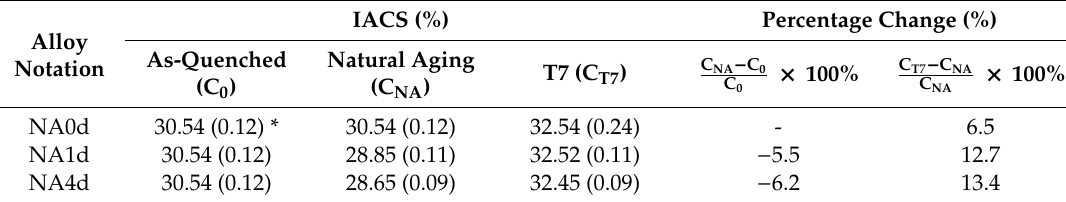
Table 3. Electrical conductivity of alloys under di ff erent heat treatment